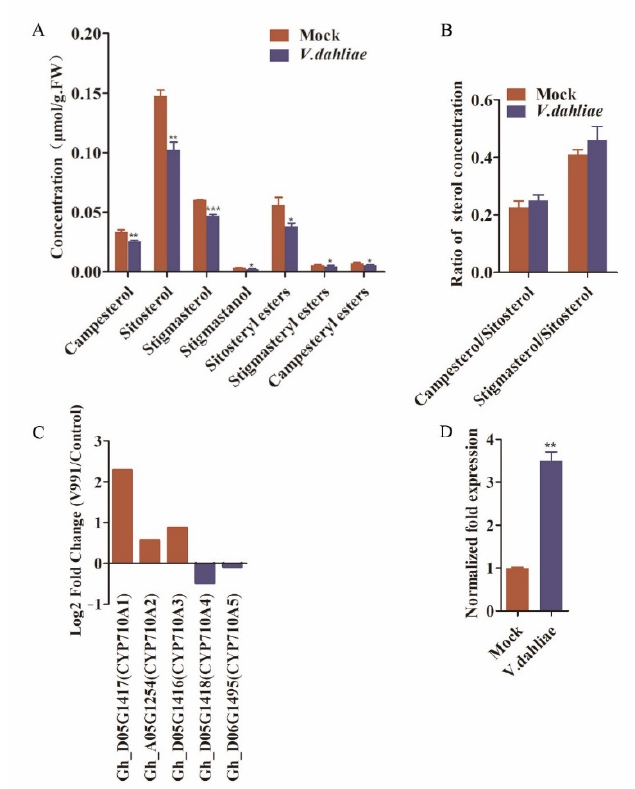
Figure 1. The changes of sterol content and GhCYP710As expression in cotton root after Verticillium dahliae inoculation. ( A ) The content changes of phytosterols. ( B ) The changes of the ratio of campesterol to sitosterol and stigmasterol to sitosterol. ( C ) The change fold of expression level in cotton root after Verticillium dahliae inoculation, which is derived from RNA-Seq. ( D ) The expression level of GhCYP710A1 was induced in cotton root after Verticillium dahliae inoculation. * represents p < 0.05, ** represents p < 0.01, *** represents p < 0.001.